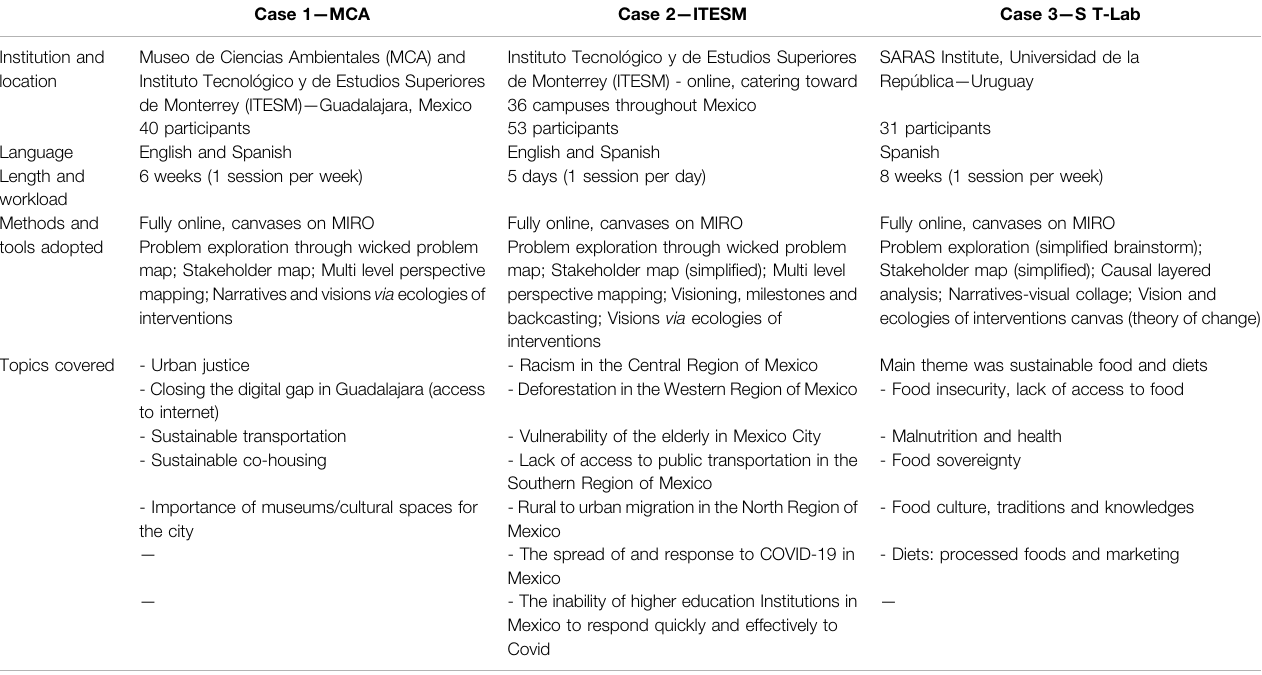
TABLE 1 | Overview and characterization of the three cases exposed: two training workshops in Mexico, and one in Uruguay, delivered online between July and November 2020 (during the COVID-19 pandemic). Case 1 —